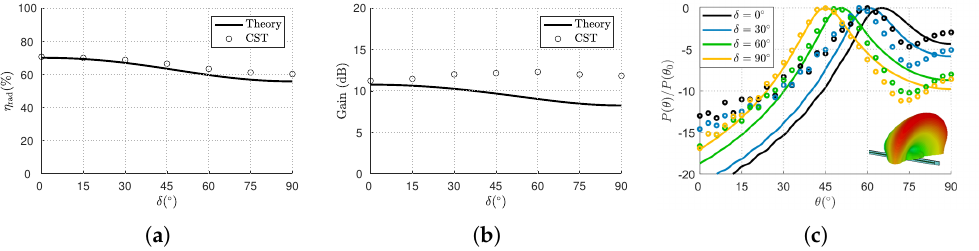
Figure 5. ( a ) Radiation efficiency η rad , and ( b ) gain (in dB) vs. NLC tilt angle δ for f = 1.049 THz. The CST results are shown as black circles, and the numerical results are shown as solid black lines. ( c ) Normalized radiation patterns at f = 1.049 THz for four different LC states—namely, δ = 0 ◦ , 30 ◦ , 60 ◦ , and 90 ◦ in black, light blue, green, and yellow, respectively. The CST results are shown as colored circles, and the analytical results are shown as solid colored lines. The inset of ( c ) shows the normalized 3-D radiation pattern for the last NLC state for which the beam peak points at approximately 45 ◦ (as expected from Figure 3c). The intensity of the normalized 3-D radiation pattern goes from − 20 dB (green) to 0 dB